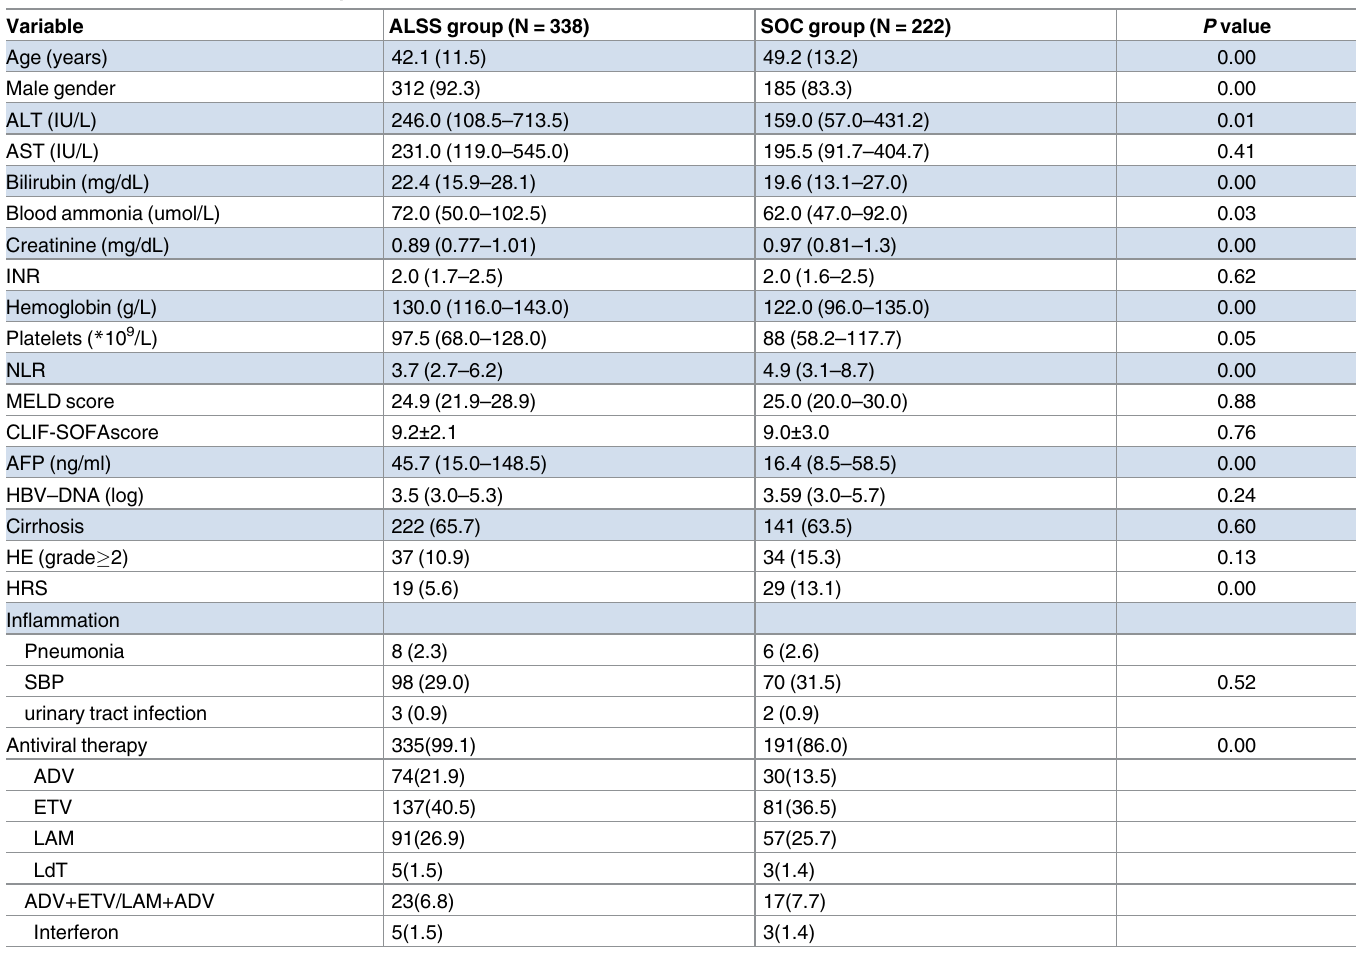
Table 1. Baseline characteristics of